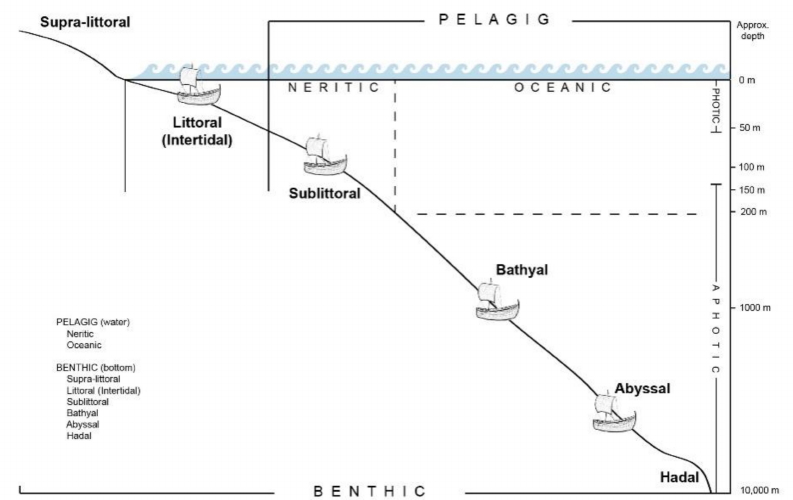
Figure 10. Classification of marine environments based on characteristics of the biozone [21] (after [99,100]). Artistic representation by A. Zisi of the Kyrenia, a 4th century BCE ancient Greek merchant